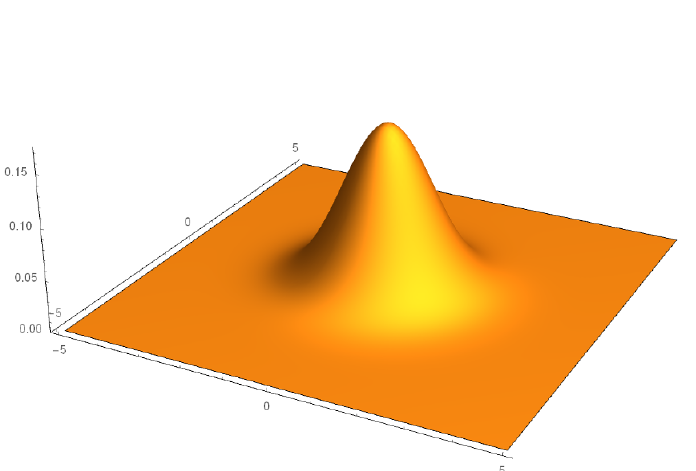
Figure 1 . Black holes as gaussian lumps. Driven by the GL instability, a black membrane develops a bulge where most of its area and mass are concentrated with a pro(cid:12)le that, when D ! 1 , is a gaussian, as shown in the (cid:12)gure. Representing Schwarzschild and Myers-Perry black holes in this manner accurately captures much of their physics, including their quasinormal